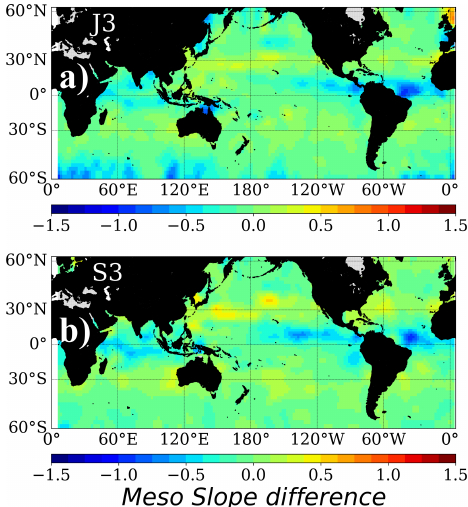
Figure 8. Difference in the mesoscale spectral slope estimates com- puted over the fitted solution (from Eq. 1) and the observed spec- trum using the simple linear fit approach of Vergara et al. (2019). (a) Jason-3 and (b)